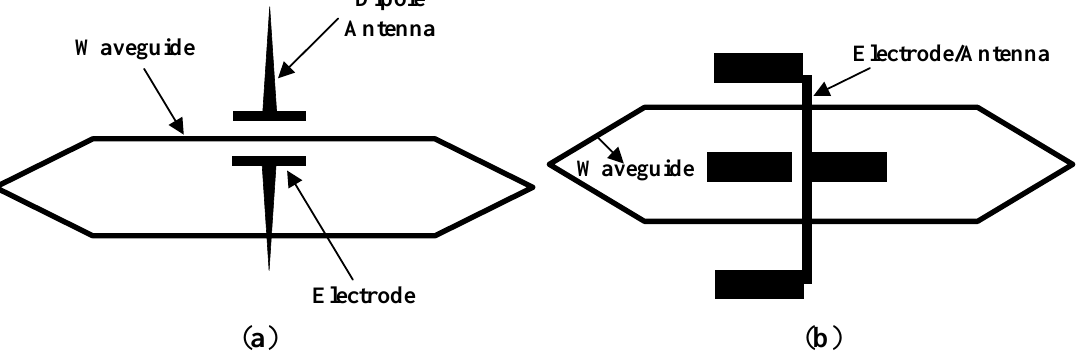
of 600 kV/m; ( b ) IOES with an E π